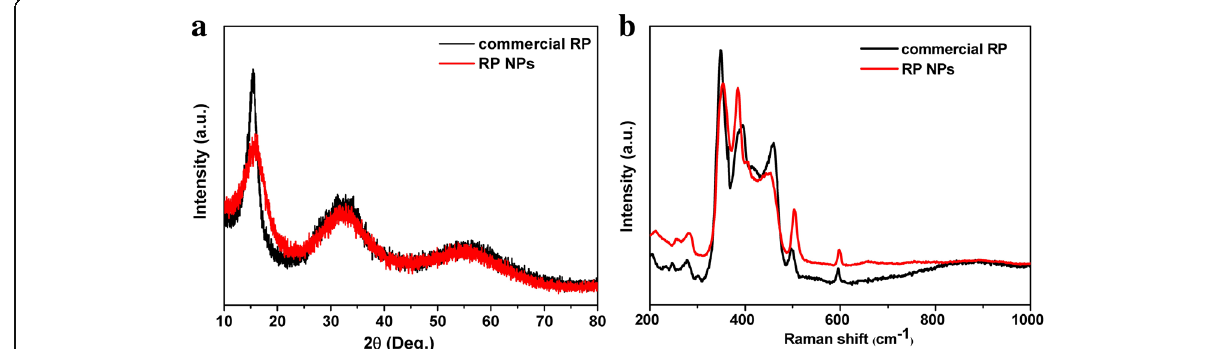
Fig. 1 Characterization of RPNPs. a XRD patterns of RPNPs and commercial RP. b Raman spectra of RPNPs and commercial